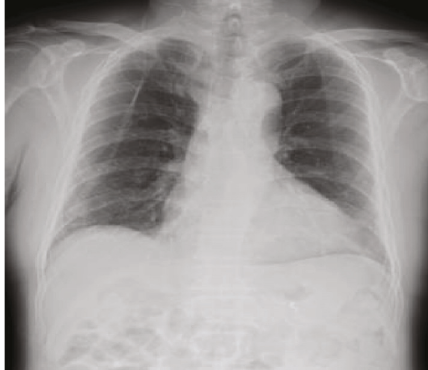
Figure 3: Chest X-ray examination in standing position does not reveal any free air.